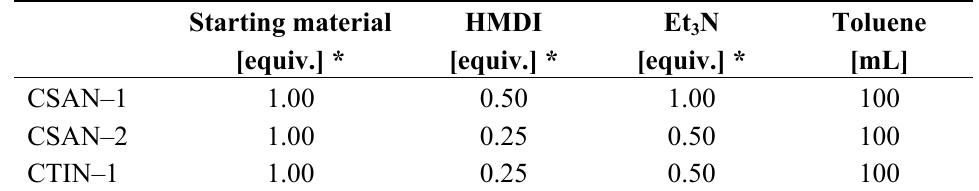
N and toluene used in the functionalization reaction. Table 1. Molar ratios of chitosan, HMDI, Et 3 Starting